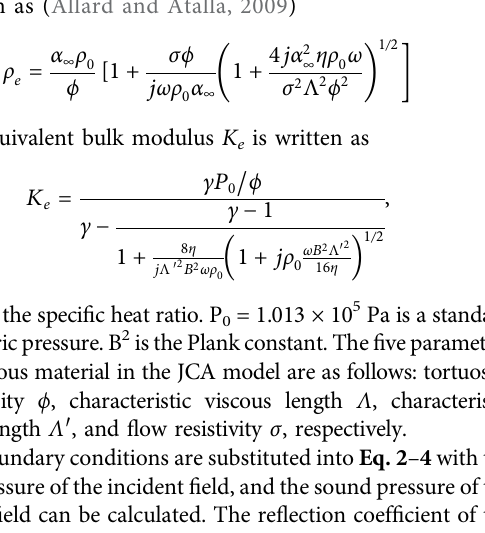
amplitude of 1.0 Pa is used as the background pressure fi eld to simulate the incident sound fi eld.